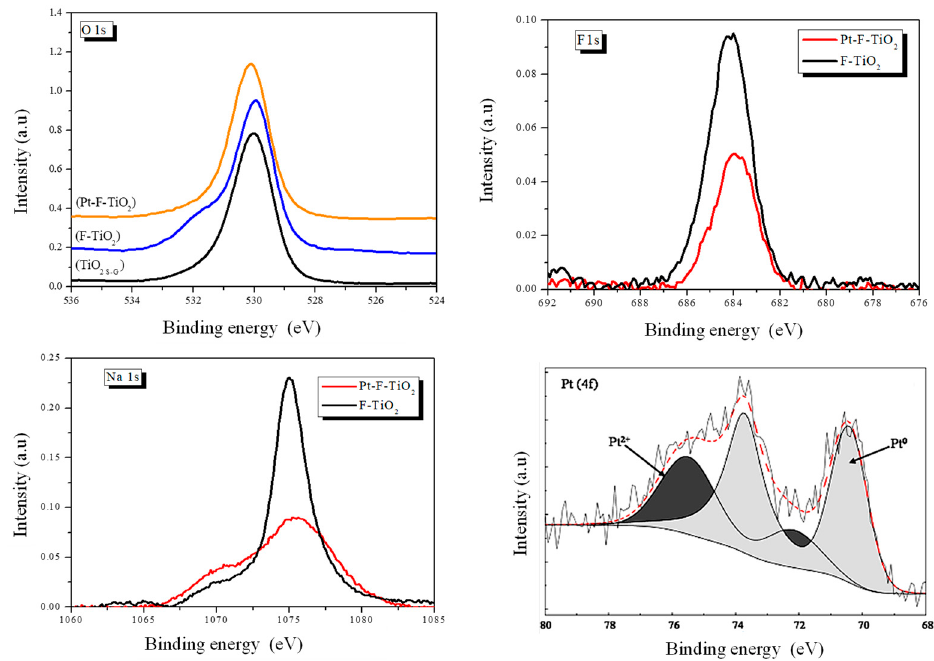
Figure 4. XPS spectra of the regions O 1s, Na 1s, F 1s and Pt4f in the photocatalysts analyzed.